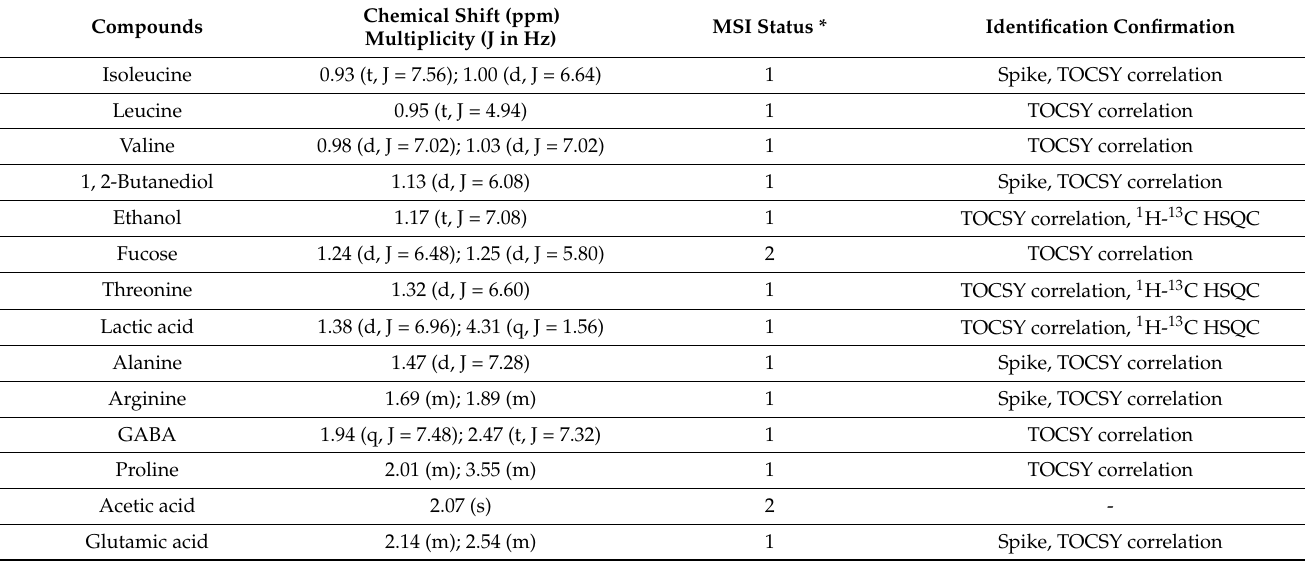
Table 1. Compounds and 1 H chemical shifts identified by 400 MHz 1D 1 H-NMR for acerola juice concentrate (300 K, D 2 O, pH 3.35, 20 mM TSP).